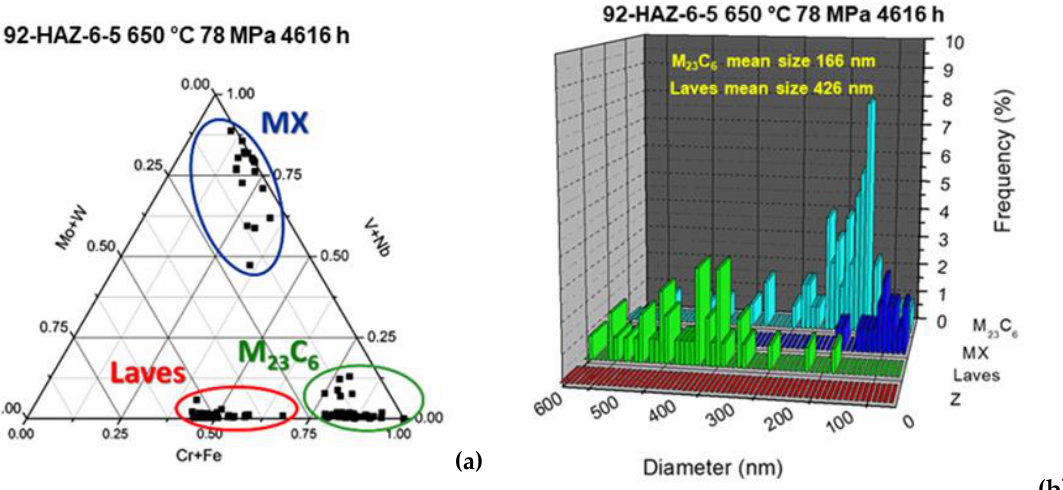
Figure 21. Failed crept cross-weld specimen 92-HAZ-6-5 650 °C 78 MPa 4616 h (sample G), ternary diagram ( a ) and size distribution ( b ) (TEM analysis).